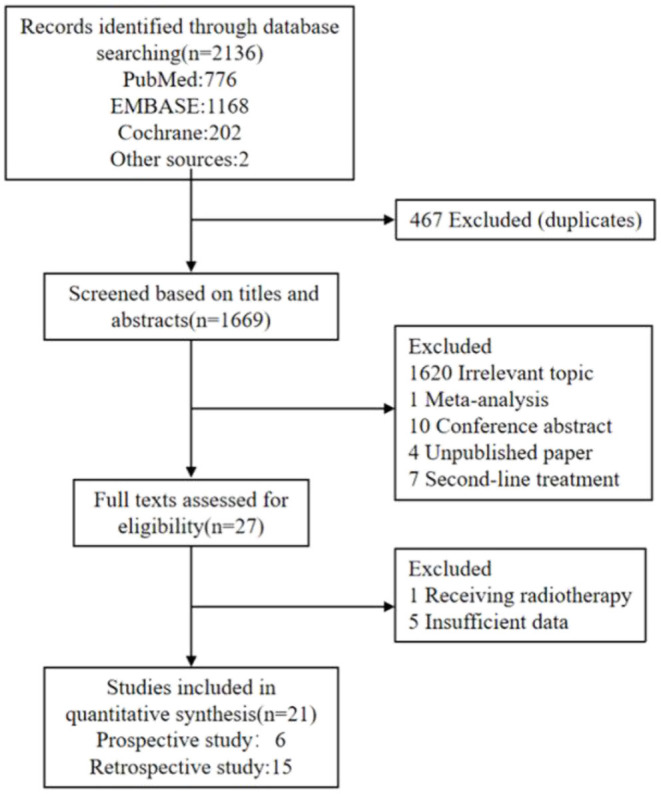
Flowchart diagram of study selection.